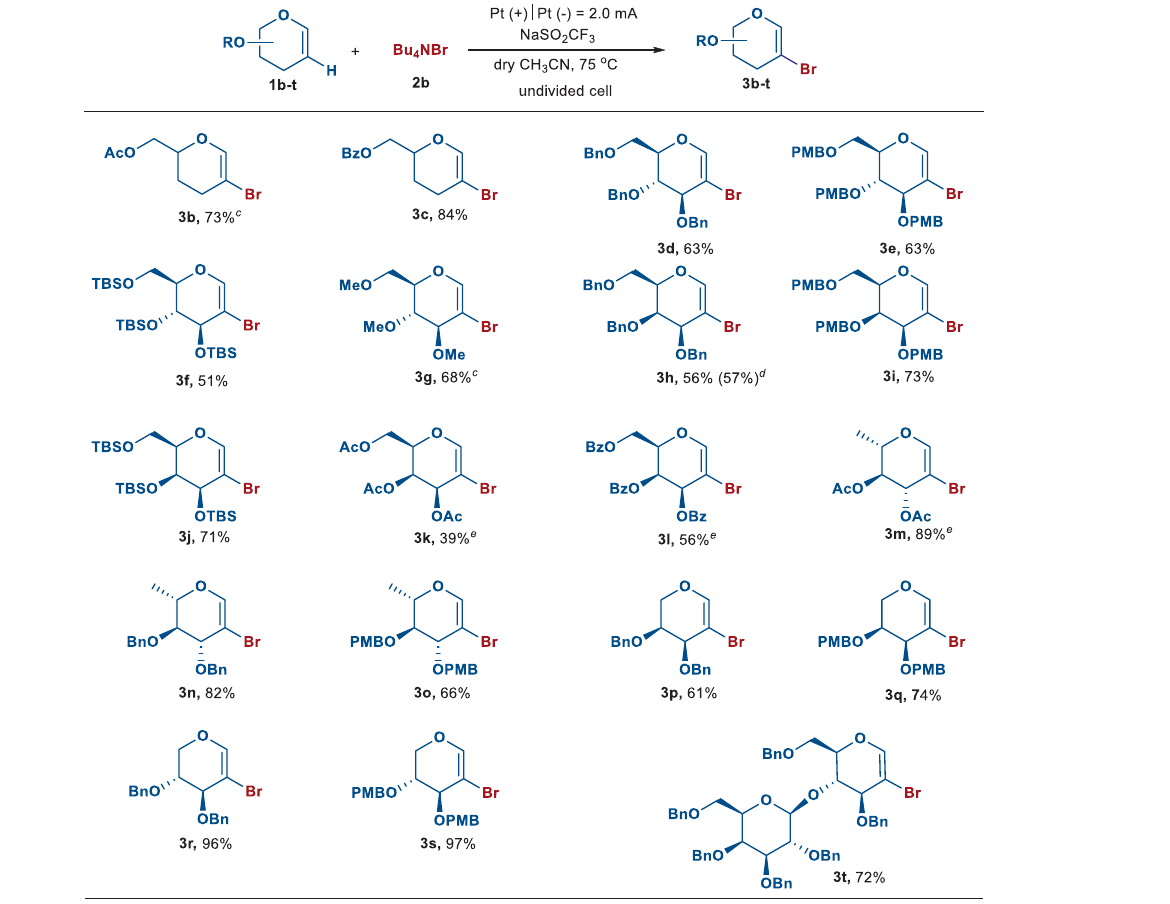
TABLE 2 | Substrate scope of glycals a,b,c,d,e